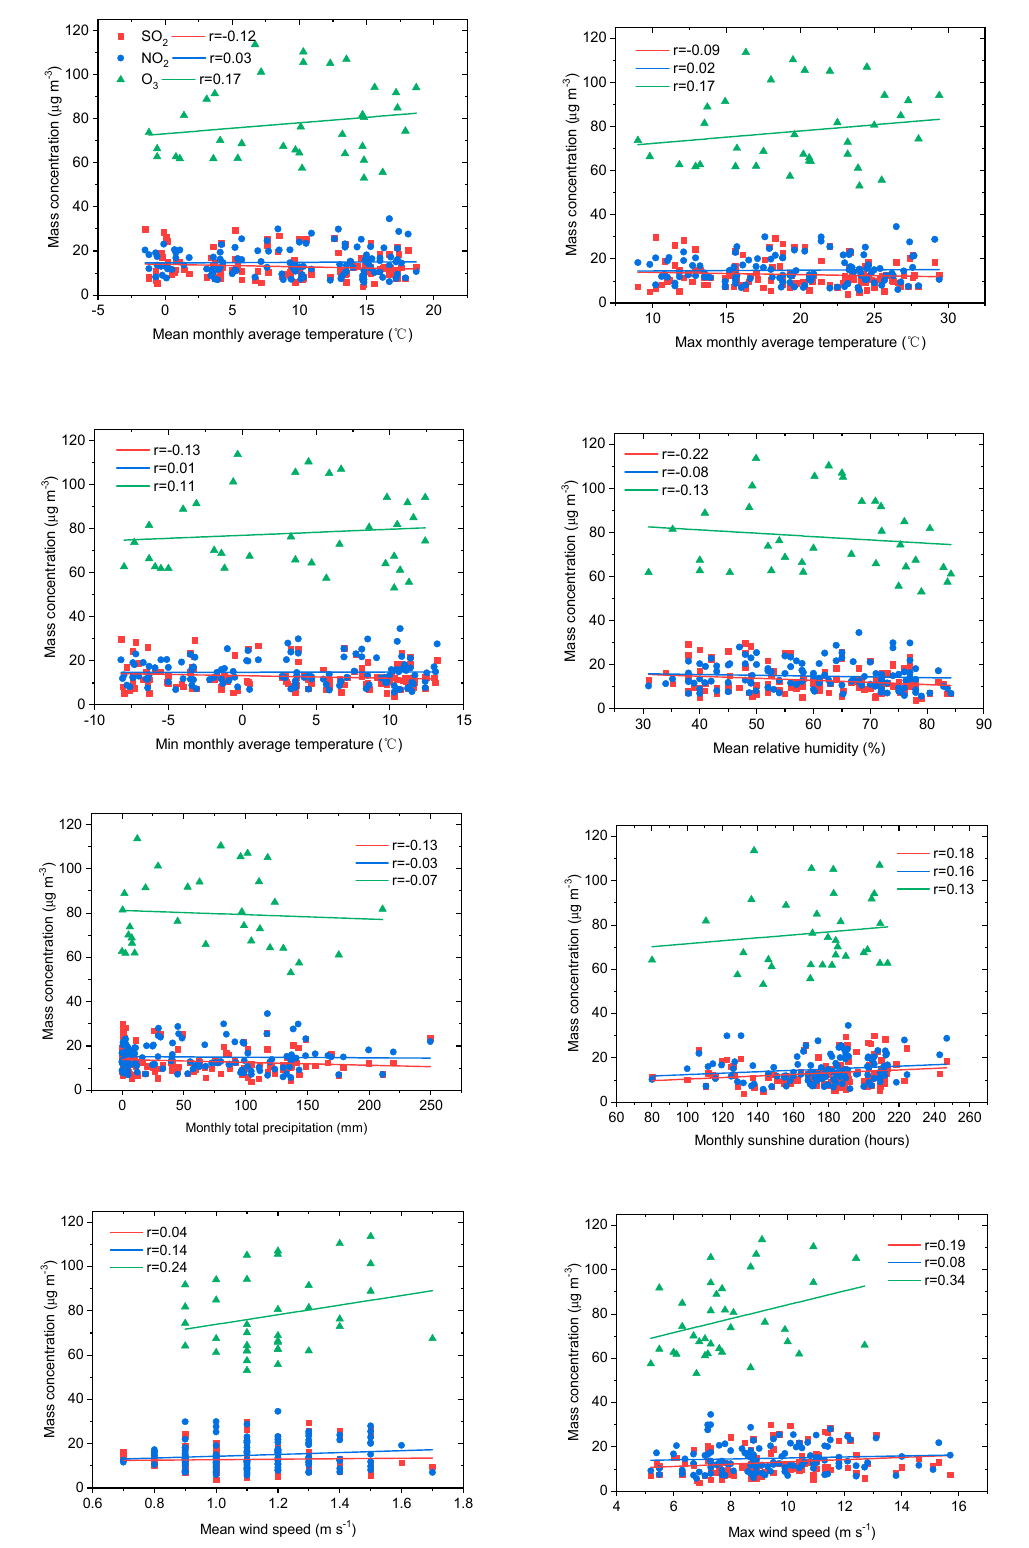
Figure 7. Relationships between SO 2 , NO 2 , O 3 and routine meteorological parameters (mean monthly average temperature, maximum and minimum monthly average temperature, mean relative humidity, monthly total precipitation, monthly sunshine duration, mean wind speed, and maximum wind speed) in Aba of the ecological zone of Western Sichuan Plateau.